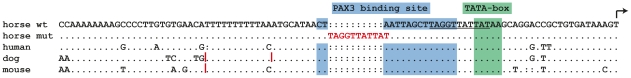
Proximal melanocyte-specific promoter of the MITF gene.The depicted region corresponds to positions −89 to +1 with respect to the transcription start site and is in reverse complementary orientation to the genomic reference sequence (ECA16:20,117,350–20,117,261; EquCab2.0). The three vertical red lines in the dog and mouse sequences represent small insertions. In some splashed white horses, an 11 bp motif shown in red replaces an adenine, which is part of a highly conserved PAX3 transcription factor binding site in the wild-type sequence. The inserted 11 bp sequence may have arisen by duplication from an identical sequence motif a few nucleotides further downstream (underlined).